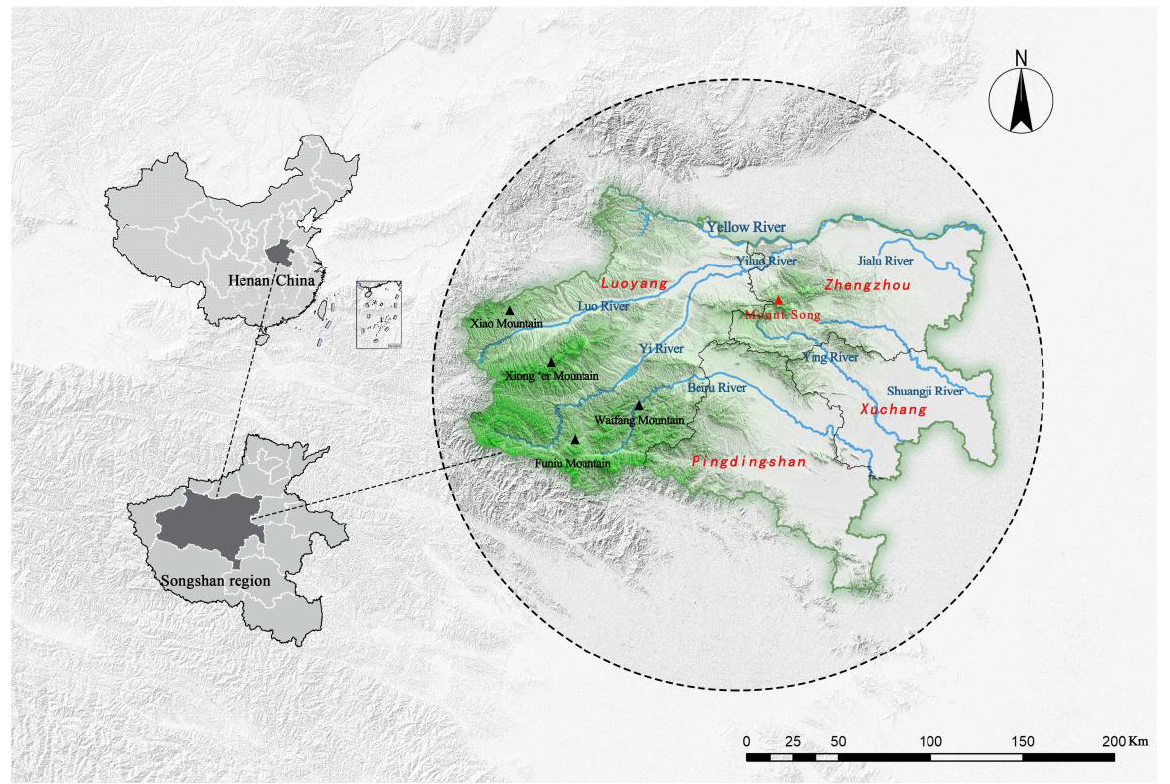
Figure 2. Location of the Songshan region.